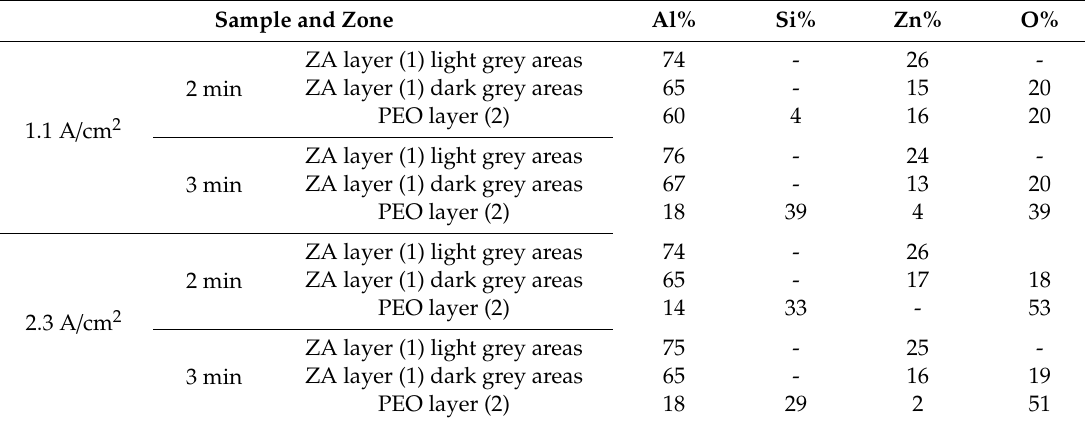
Table 2. EDS semi-quantitative results (wt %) on the various samples. Sample and